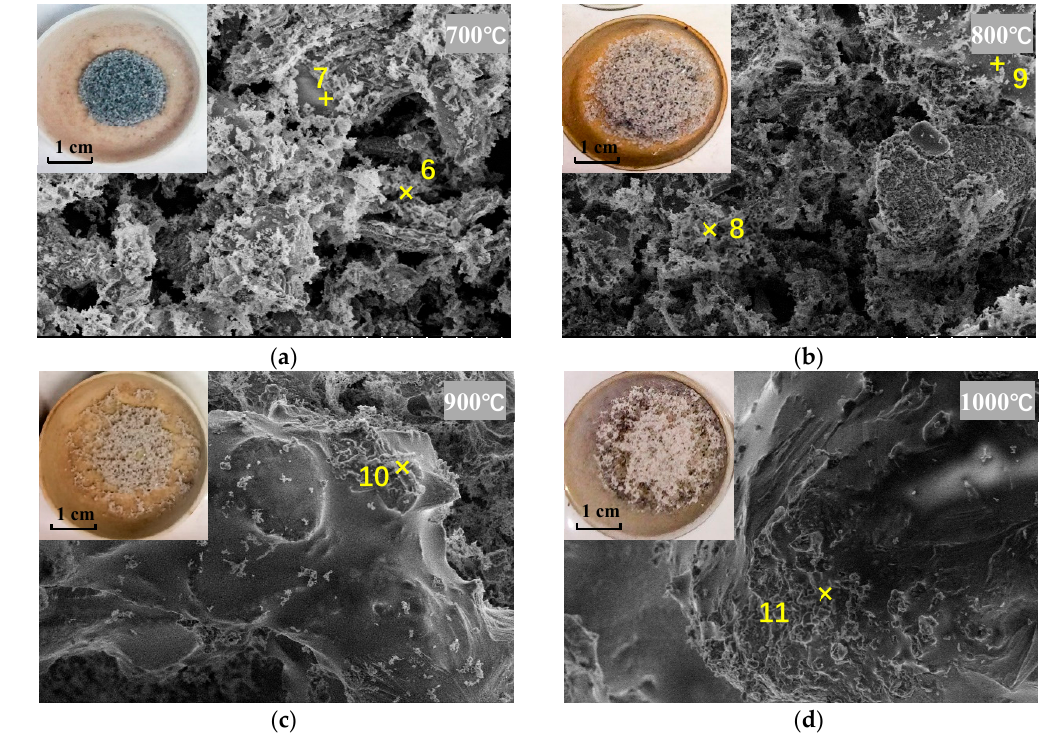
Figure 4. SEM images of WS GL ashes: ( a ) WS GL ash heated to 700 °C, ( b ) WS GL ash heated to 800 °C, ( c ) WS GL ash heated to 900 °C, and ( d ) WS GL ash heated to 1000 °C.